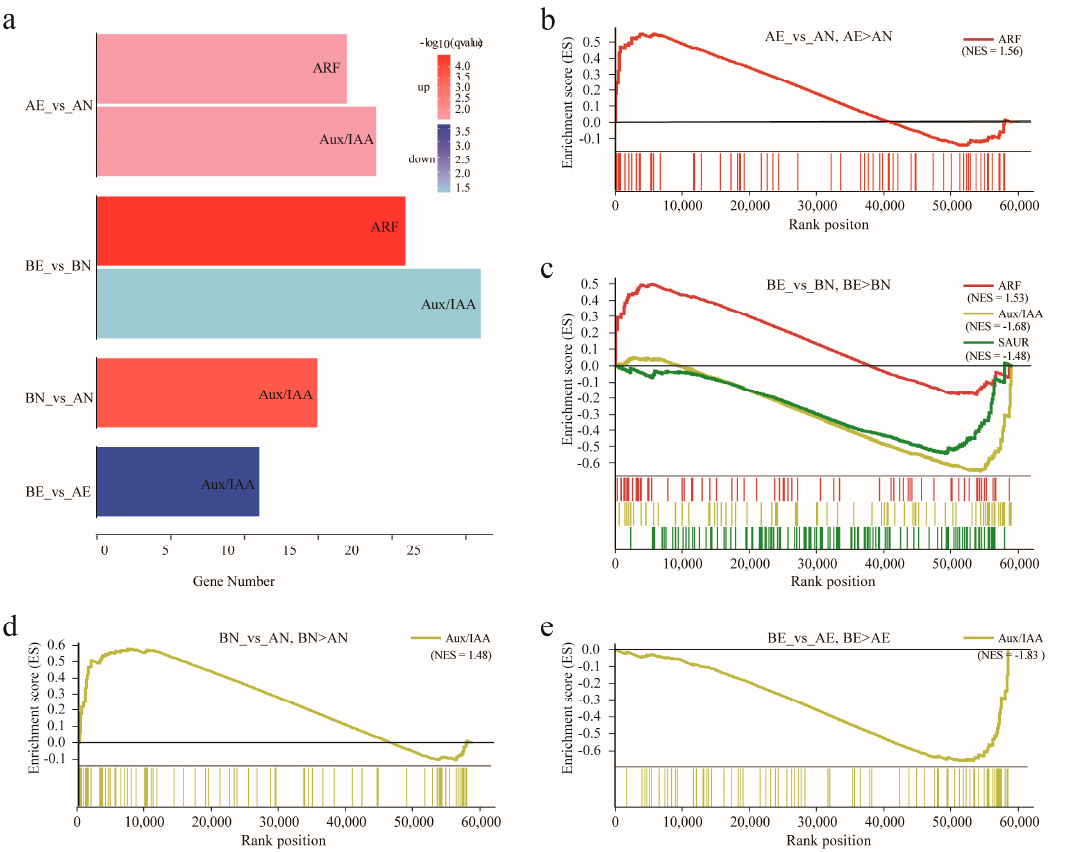
Figure 6. Enrichment results of ARF , Aux / IAA , GH3 , and SAUR genes during the acquisition of embryogenic potential. ( a ) Over-representation analysis plots of the hypergeometric test based on di ff erentially expressed ARF , Aux / IAA , GH3 , and SAUR genes. Enriched auxin early response gene families are shown by the colored bars, enriched families in the upregulated and downregulated DEGs are colored by red and blue, respectively. The di ff erent shade of the red or blue color indicates the di ff erent degree of enrichment represented by the minus of log 10 transformed q values. ( b–e ) GSEA plots of ARF , Aux / IAA , GH3 , and SAUR family gene sets in di ff erent comparison pairs, significant enriched family gene sets are shown in the enrichment score (ES) plots by di ff erent colors. Normalized enrichment scores (NES) for each enriched family set is shown in brackets. A positive NES value indicates that the family gene set was positively associated with the indicated relativeness in the comparison pair. A negative NES value indicates that the family gene set was negatively associated with the indicated relativeness in the comparison